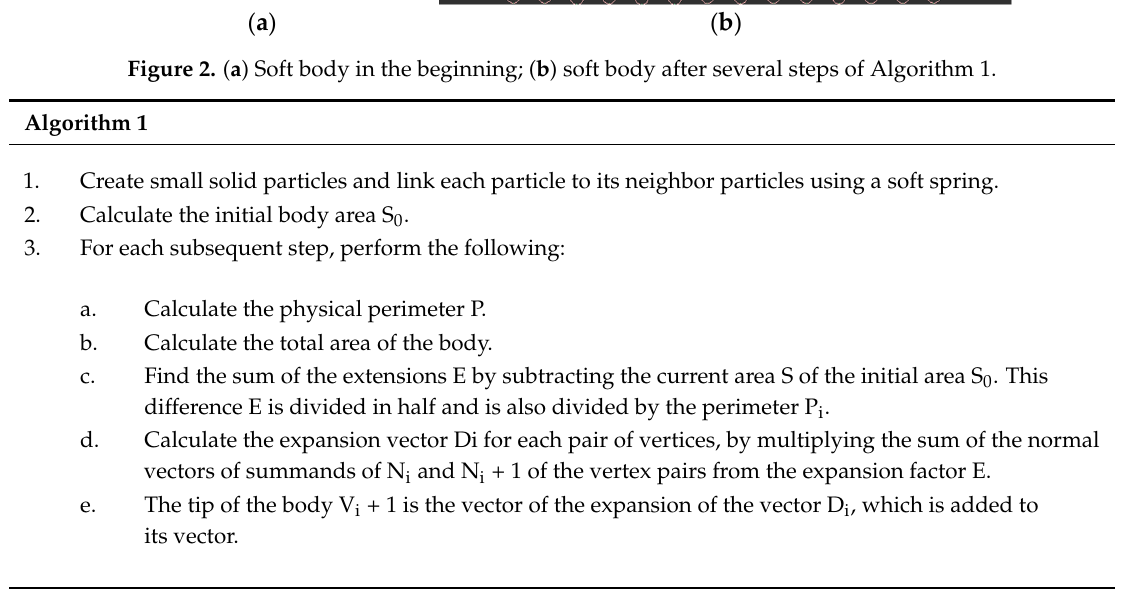
Figure 2. ( a ) Soft body in the beginning; ( b ) soft body after several steps of Algorithm 1.